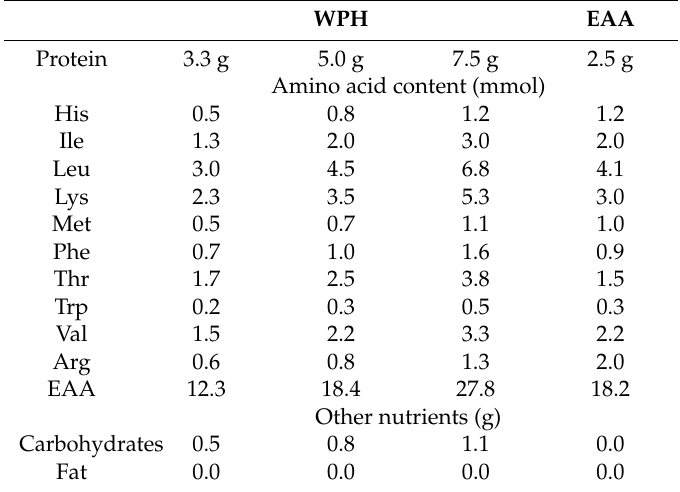
Table 2. The essential amino acid content and other nutrients of the test solutions 1